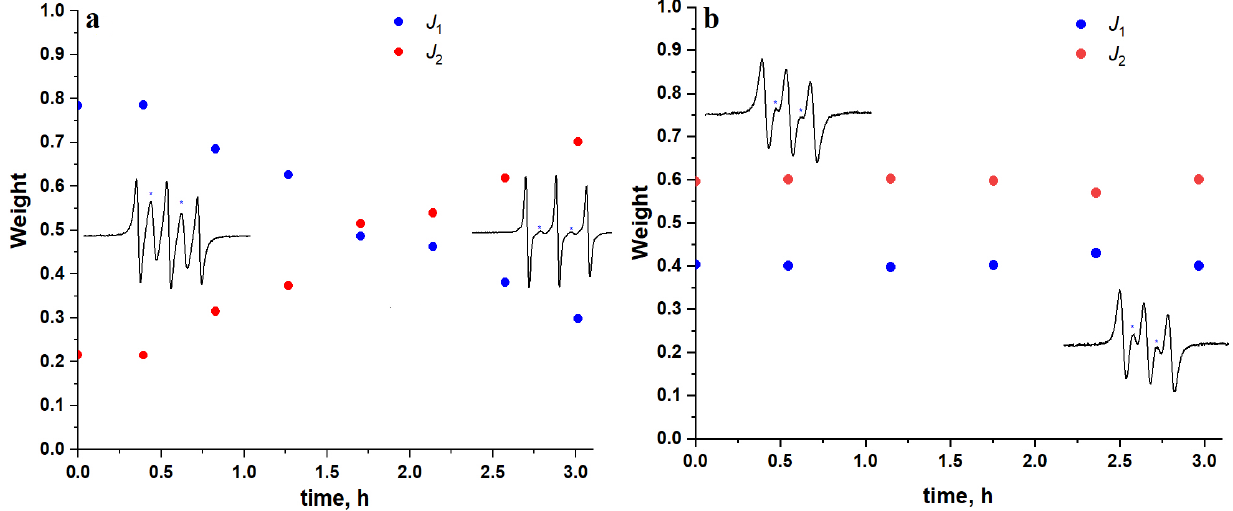
Figure 9. Dependence of the ratio of two components with different J on time in the ring-opening reaction for radical 3 ( a ) and 4 ( b ).